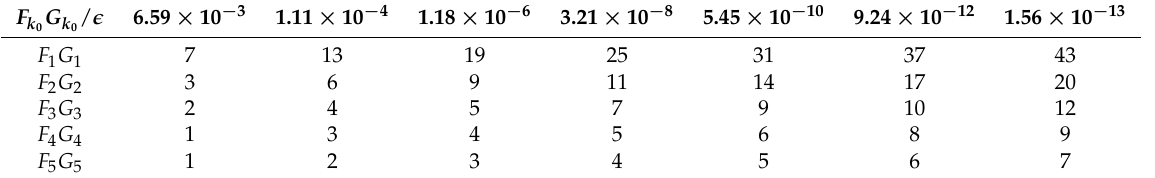
Table 9. Subdivision depth of 4-point ternary subdivision